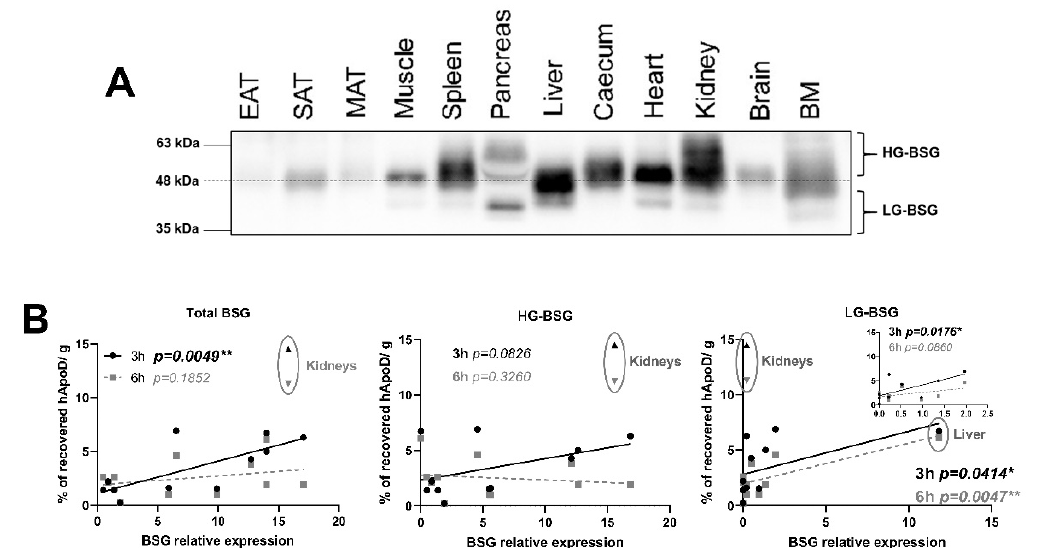
Figure 6. hApoD tends to accumulate in tissues expressing underglycosylated Basigin. ( A ) Immunoblot of Basigin (BSG) in its multiple glycosylated forms (HG, highly glycosylated; LG, lowly glycosylated) in various tissues, including epididymal adipose tissue (EAT), subcutaneous adipose tissue (SAT), mesenteric adipose tissue (MAT), and bone marrow (BM). Each well contained whole protein extracts from 20 μ g of tissue. A representative immunoblot is shown (n = 4 animals). ( B ) Correlations between average hApoD accumulation (% of recovered radioactivity per gram of tissue) and average expression level of different classes of glycosylated Basigin in various tissues, 3 (black) and 6 h (grey) after IV injection. Inset: liver data eliminated from the correlation. Pearson’s product moment correlations are presented: * p < 0.05, ** p < 0.01 (n = 4 animals).